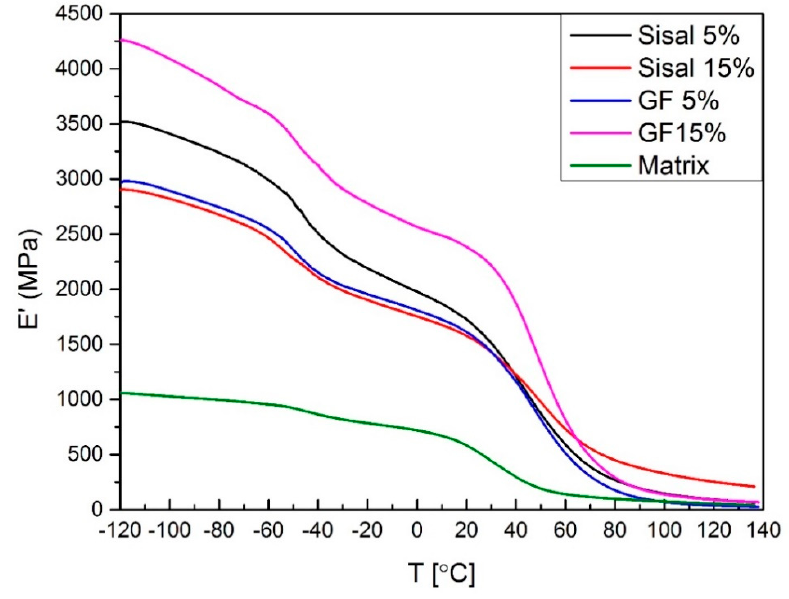
Figure 8. Storage modulus values of sisal and GF composites.